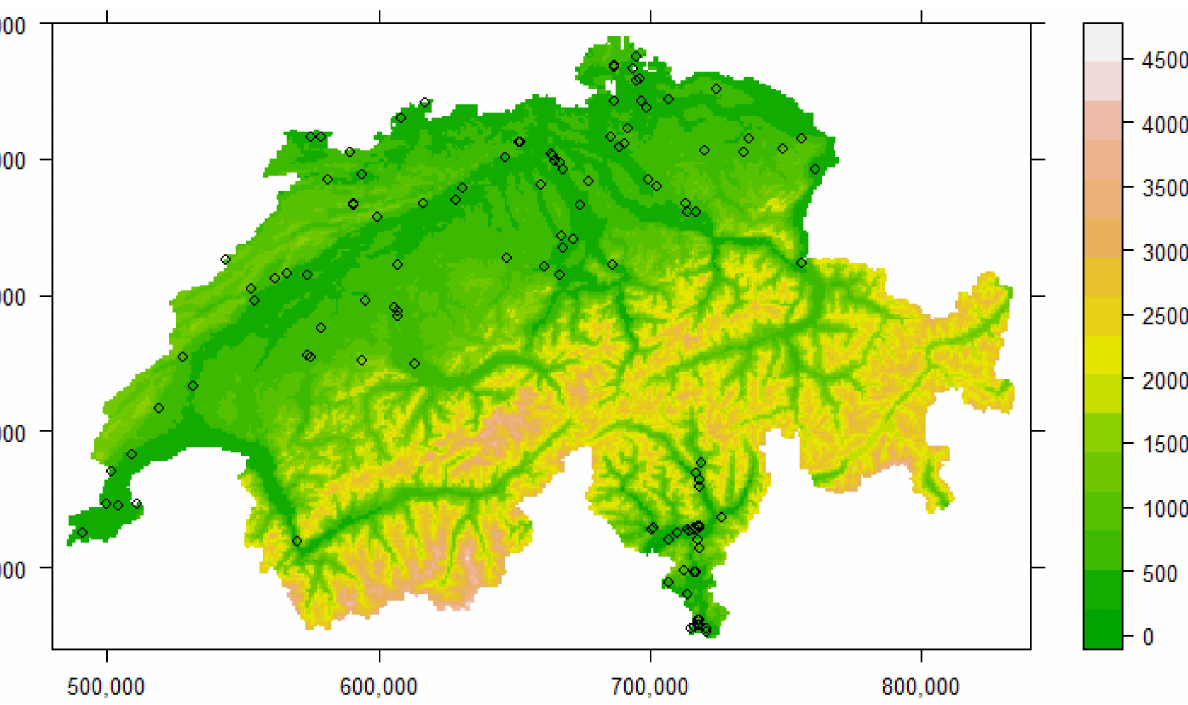
Figure A1. Map of Switzerland and the study sites. See text for further